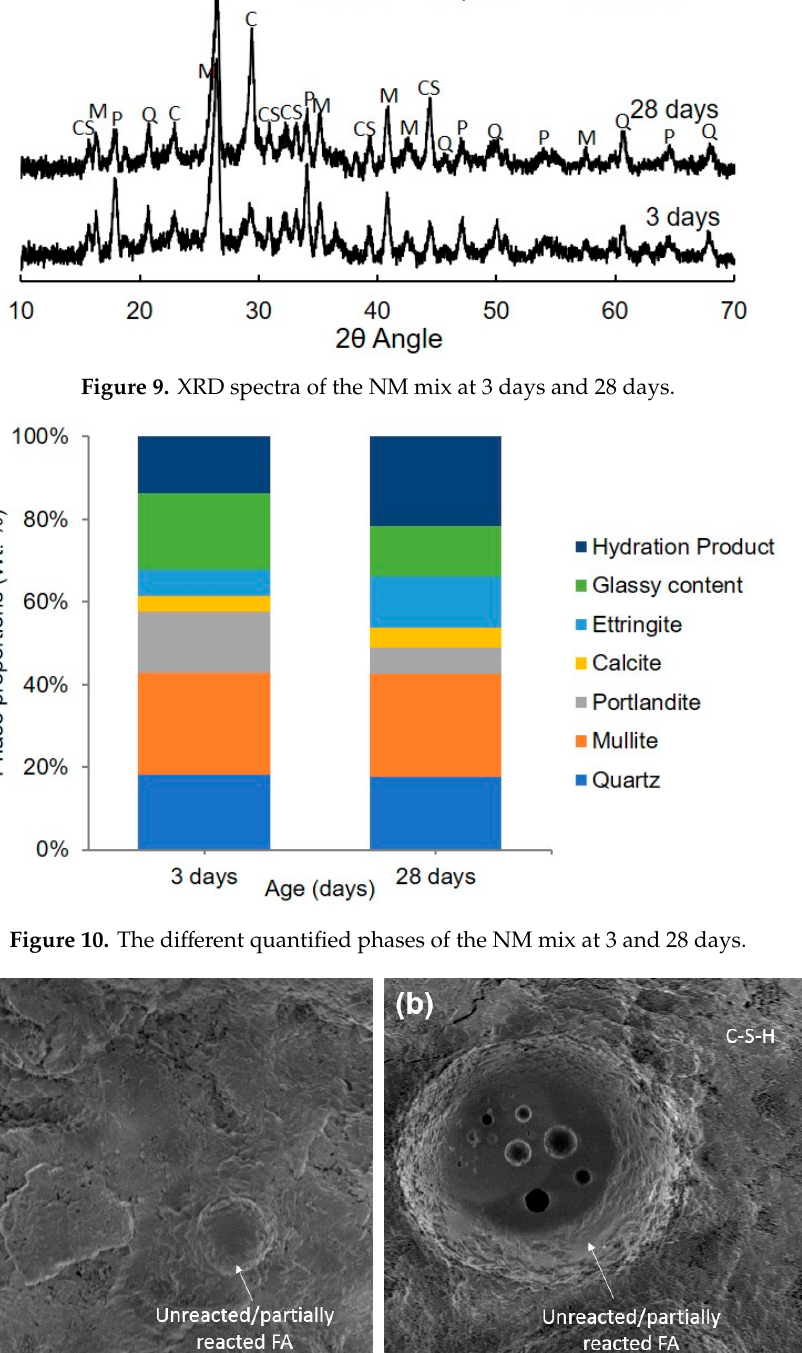
Figure 9. XRD spectra of the NM mix at 3 days and 28 days.